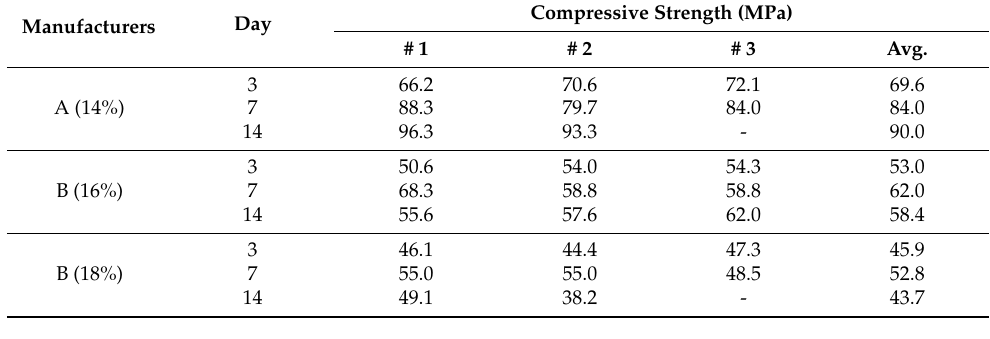
Table 3. Results of compressive strength test with cubic mold.